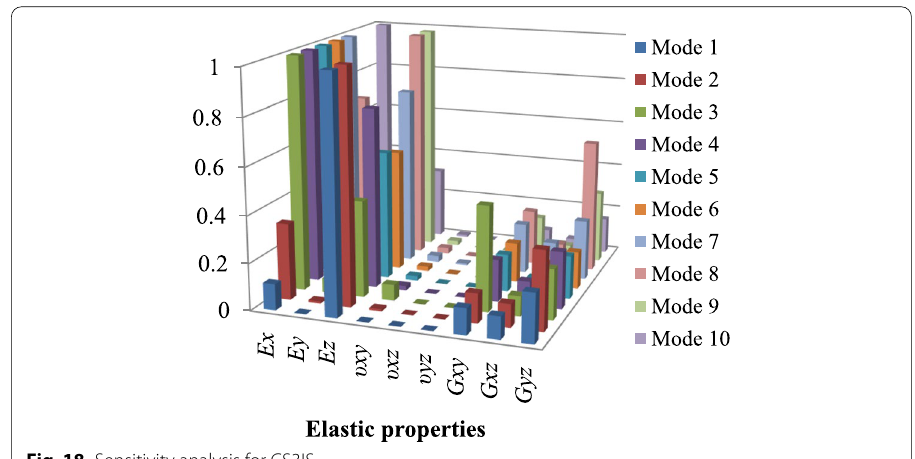
Fig. 18 Sensitivity analysis for